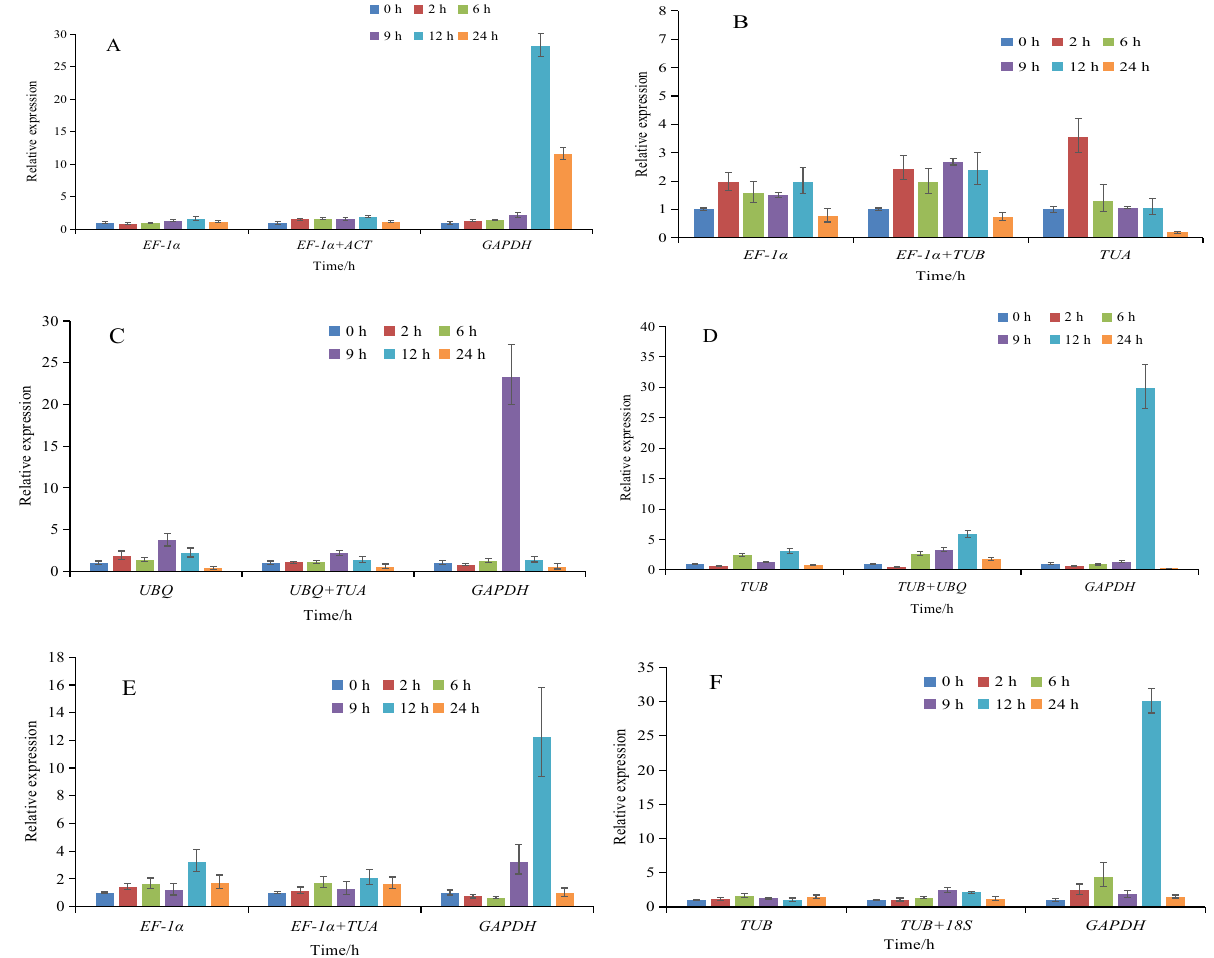
Figure 7. Expression of LcCu/Zn-SOD1 gene under different stresses using validated reference genes for data normalization. ( A ) Expression of LcCu/Zn-SOD1 gene under heat stress using validated reference genes ACT , EF-1α , and GAPDH . ( B ) Expression of LcCu/Zn-SOD1 gene under cold stress using validated reference genes TUA , EF-1α , and TUB . ( C ) Expression of LcCu/Zn-SOD1 gene under salt stress using validated reference genes TUA , UBQ , and GAPDH . ( D ) Expression of LcCu/Zn-SOD1 gene under H 2 O 2 stress using validated reference genes TUB , UBQ , and GAPDH . ( E ) Expression of LcCu/Zn-SOD1 gene under ABA stress using validated reference genes TUA , EF-1α , and GAPDH . ( F ) Expression of LcCu/Zn-SOD1 gene under drought stress using validated reference genes TUB , 18S , and GAPDH